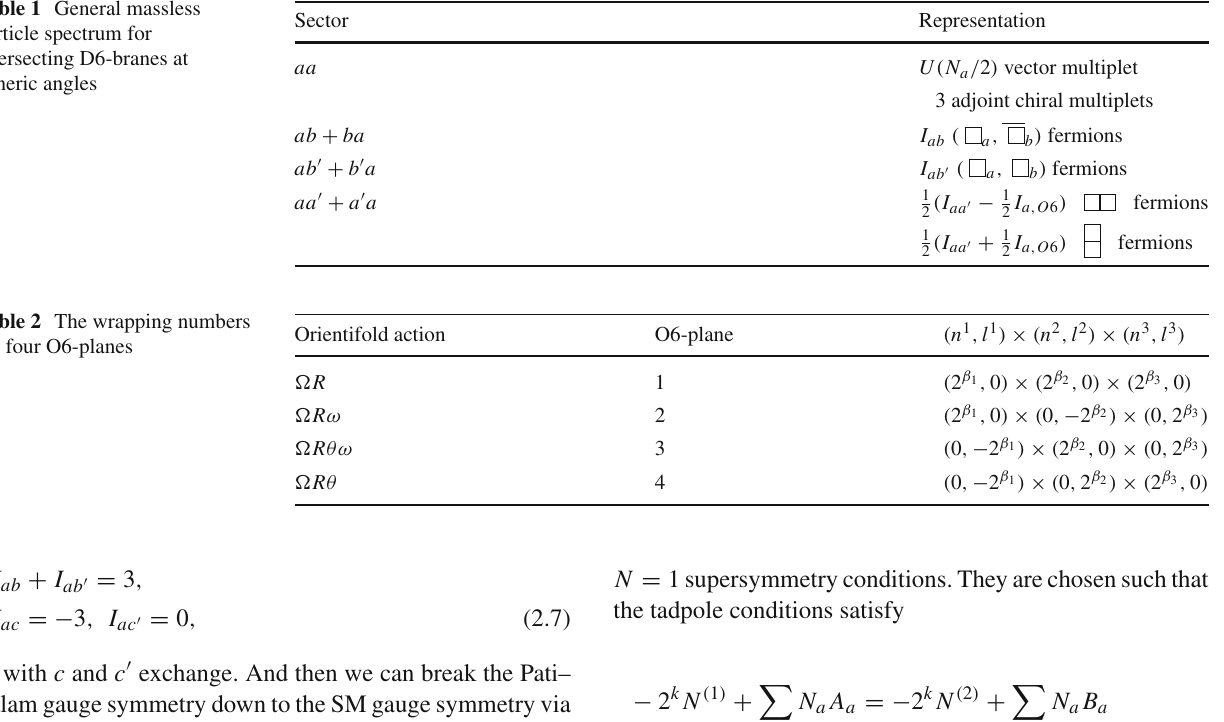
Sector Representation